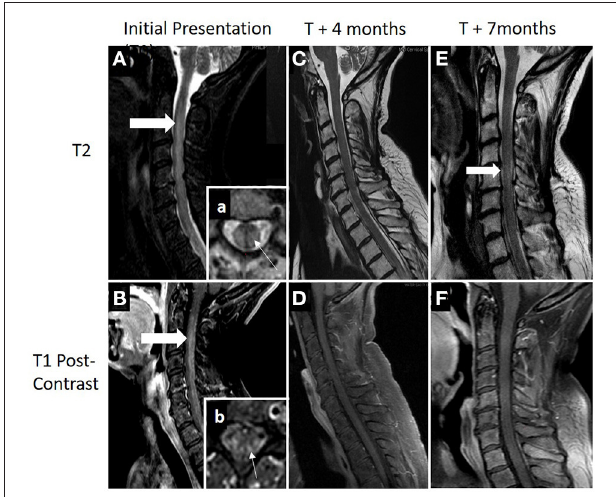
FIGURE 2 | (A,B) MRI demonstrating an longitudinally extensive T2 lesion (top row; thick white arrow) with associated contrast enhancement (bottom row; thick white arrow). Box (a), axial view showing a typical presence of transverse myelitis involving a central lesion, involving more than 2/3 of the cross-sectional area (thin white arrow). Box (b), areas of patchy contrast enhancement concentrated within areas of the posterior cord (thin white arrow). (C,D) Patient had clinical and radiographical improvement at 4 months after diagnosis following acute treatment with plasma exchange, high-dose steroids, and adjuvant chemotherapy. (E,F) Seven months after diagnosis and 1 month following completion of her adjuvant chemotherapy, she was hospitalized again for worsening of lower extremity weakness and pain. Repeat cervical spine MRI showed some worsening T2 signal change within the cord (thick white arrow) with no evidence of contrast enhancement. Acute therapy with plasma exchange and intravenous steroids were given over 5 days followed by rituximab induction (1,000mg on days 0 and 14). Additional cancer screening with full body PET scan remained negative with clinical